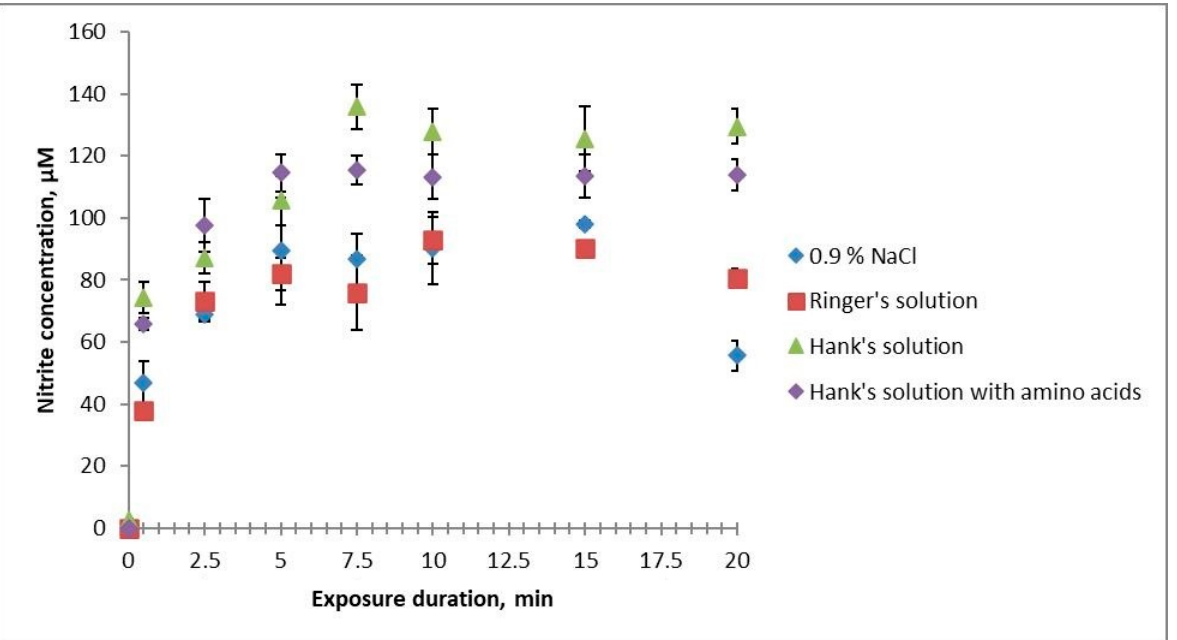
Figure 1. Dependence of the concentration of nitrite ions in the studied solutions on their cold plasma treatment times. treatment